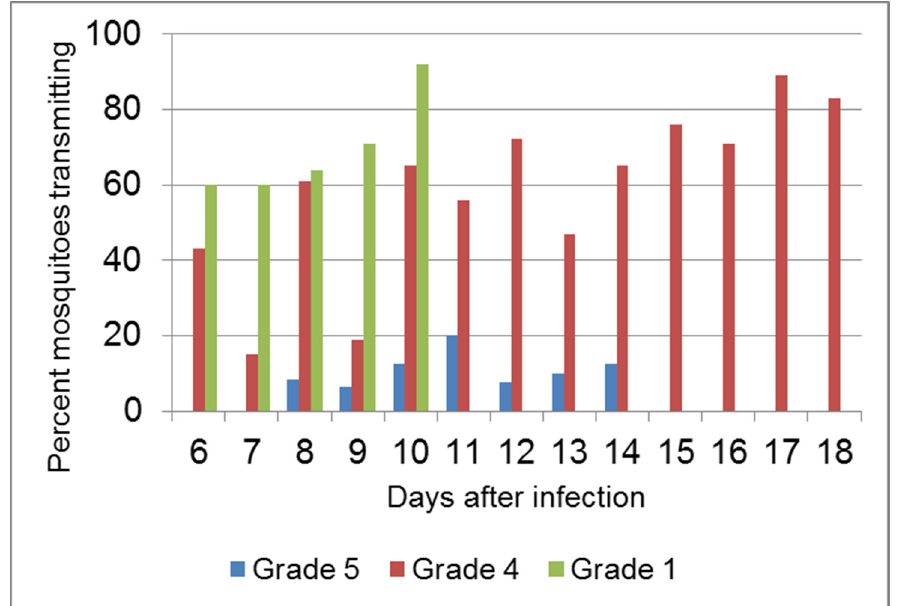
Figure 2. Mosquito transmissibility of Myxoma virus. The percentage of mosquitoes that successfully transmitted virus following feeding on cutaneous lesions of rabbits infected with grade 1, grade 4 or grade 5 viruses is shown. Data are from [134]. Figure is reprinted from Antiviral Research [64] (with permission from